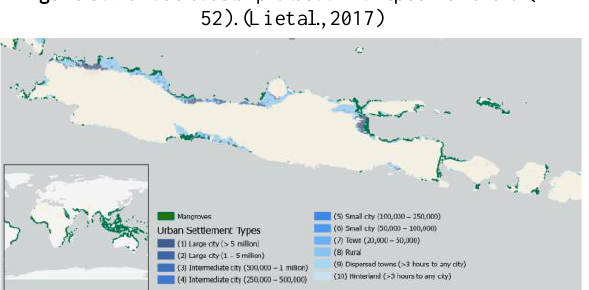
Figure 6. Global Mangrove Forests Distribution in